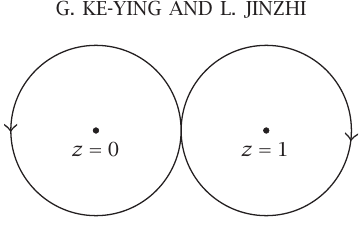
Figure 2.1 . A directed path L